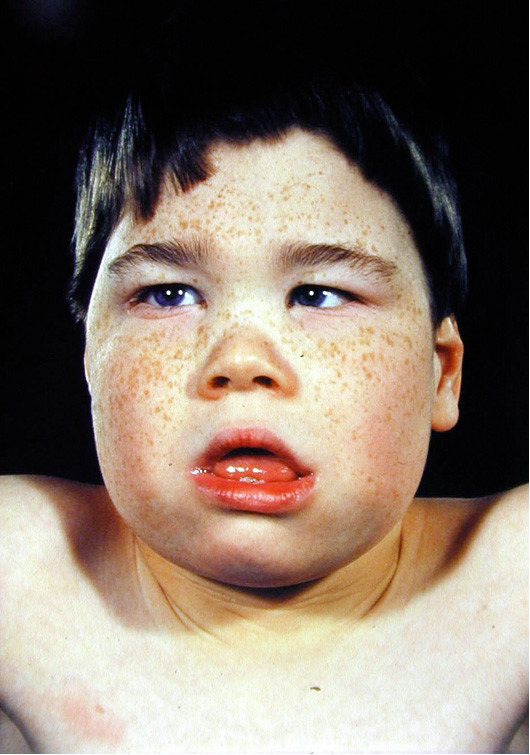
Child of 8 yrs with the characteristic facial features of ATR-X syndrome. Note the upswept frontal hair line, hypertelorism, epicanthic folds, flat nasal bridge, small triangular upturned nose, tented upper lip, everted lower lip and hypotonic facies.